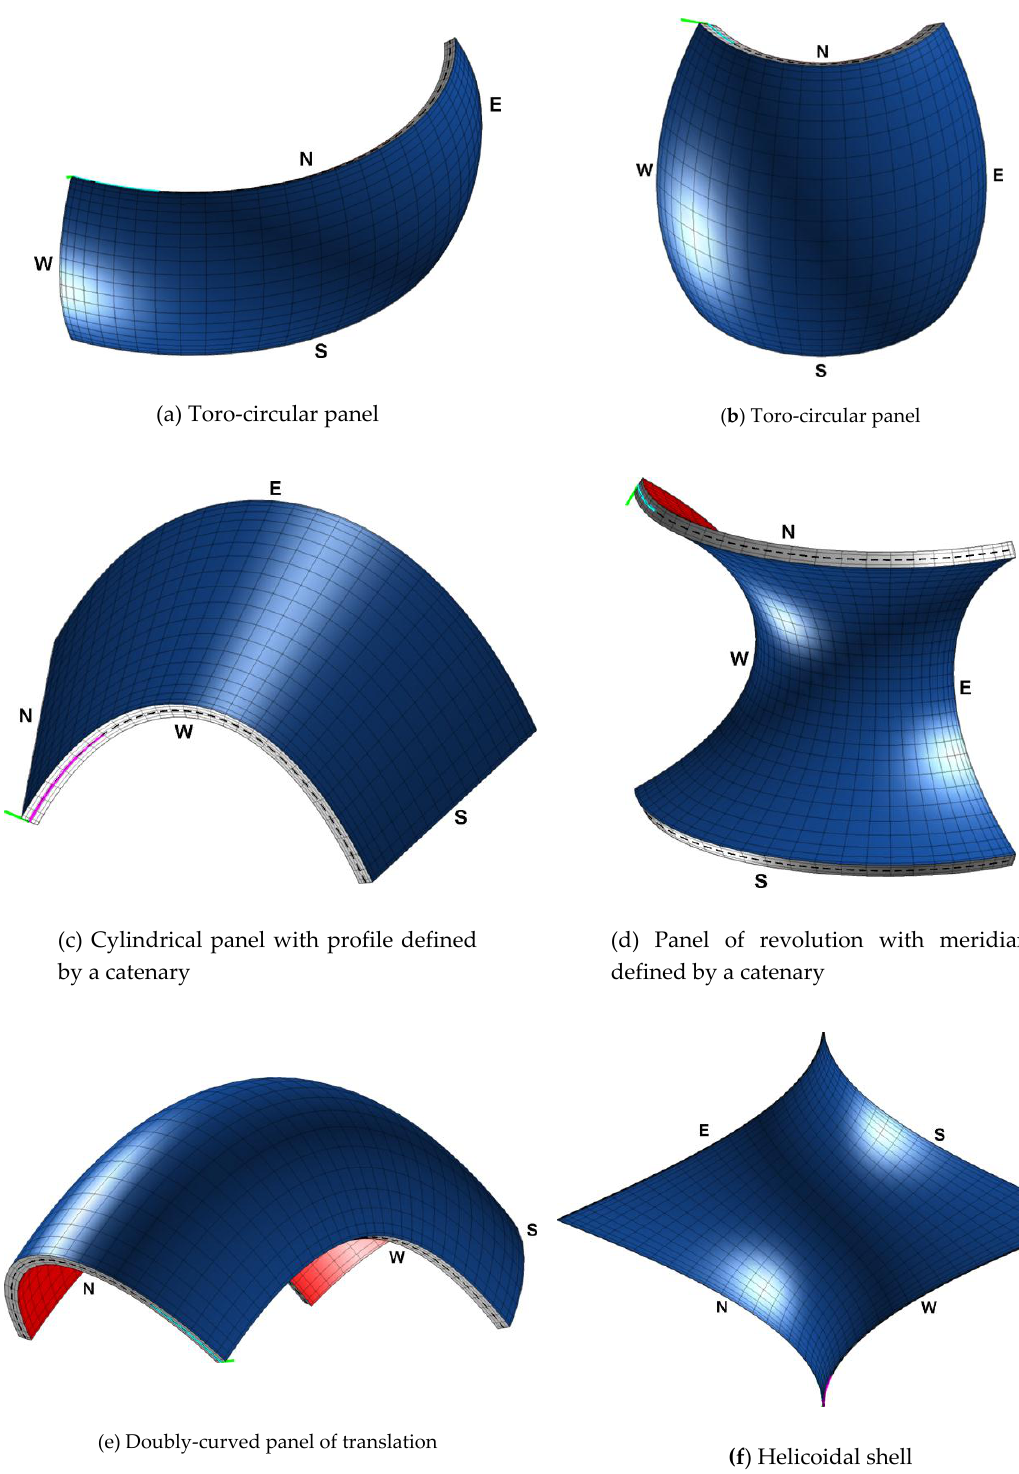
Figure 4. Definition of the geometry of six shell structures: Generalized Differential Quadrature (GDQ) grid and local coordinate reference system representation.